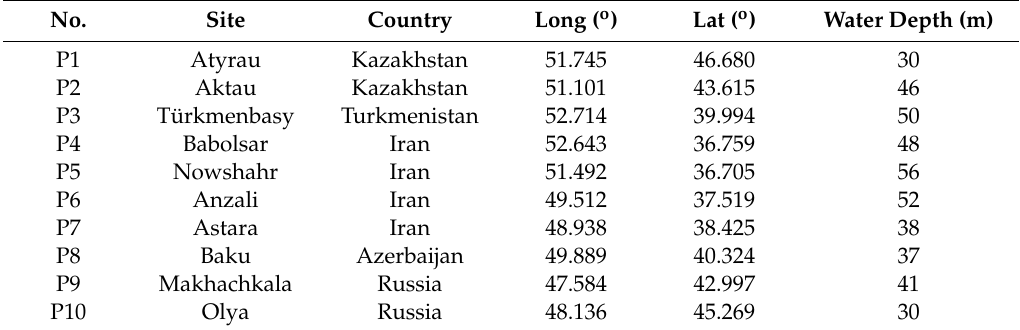
Figure 1. The Caspian Sea and the reference sites considered for assessment, where: ( a ) bathymetry map [25]; ( b ) water depths corresponding to each reference site [25]; ( c ) number of inhabitants corresponding to the reference area considered [26]. Table 1. The main characteristics of the considered sites located at a distance of 5 km from